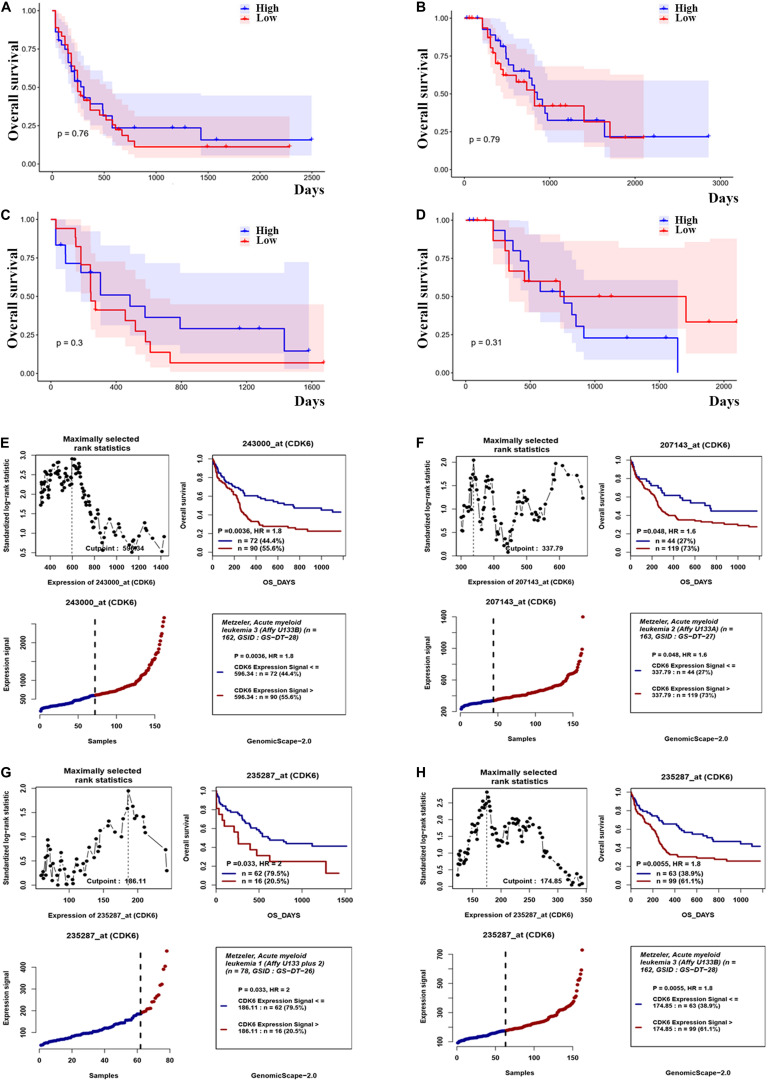
The effect of CDK6 expression on overall survival in non-APL AML patients. (A) Kaplan–Meier analysis of OS in chemotherapy only group in non-APL AML patients [CDK6high (n = 36) vs. CDK6low (n = 36): p = 0.76] (cut point: median CDK6 expression level). (B) Kaplan–Meier analysis of OS in auto-/allo-HSCT group in non-APL AML patients [CDK6high (n = 31) vs. CDK6low (n = 32): p = 0.79] (cut point: median CDK6 expression level). (C) Kaplan–Meier analysis of OS in chemotherapy only group in cytogenetically normal AML patients [CDK6high (n = 17) vs. CDK6low (n = 18): p = 0.3] (cut point: median CDK6 expression level). (D) Kaplan–Meier analysis of OS in auto-/allo-HSCT group in cytogenetically normal AML patients [CDK6high (n = 17) vs. CDK6low (n = 18): p = 0.3] (cut point: median CDK6 expression level). (E) The survival analysis of probe 243000_at of 162 cytogenetically normal AML (CN-AML) patients using the online web tool GenomicScape (cut point: 596.34, p = 0.0036, HR = 1.8); (F) the survival analysis of probe 207143_at of 162 cytogenetically normal AML (CN-AML) patient (cut point: 337.79, p = 0.048, HR = 1.6). (G) The survival analysis of probe 235287_at of 78 cytogenetically normal AML (CN-AML) patients using the online web tool Genomicscape (cut off: 596.34, p = 0.033, HR = 2). (H) The survival analysis of probe 235287_at of 162 cytogenetically normal AML (CN-AML) patients using the online web tool Genomicscape (cut point: 596.34, p = 0.0055, HR = 1.8).